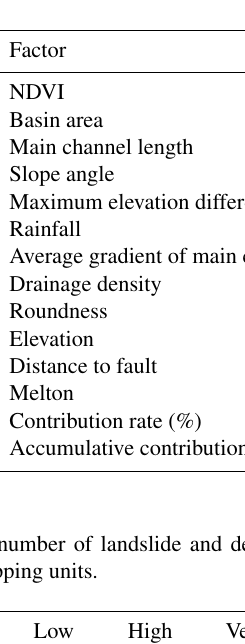
Table 8. The correlation coefficients between common factors and primitive variables.